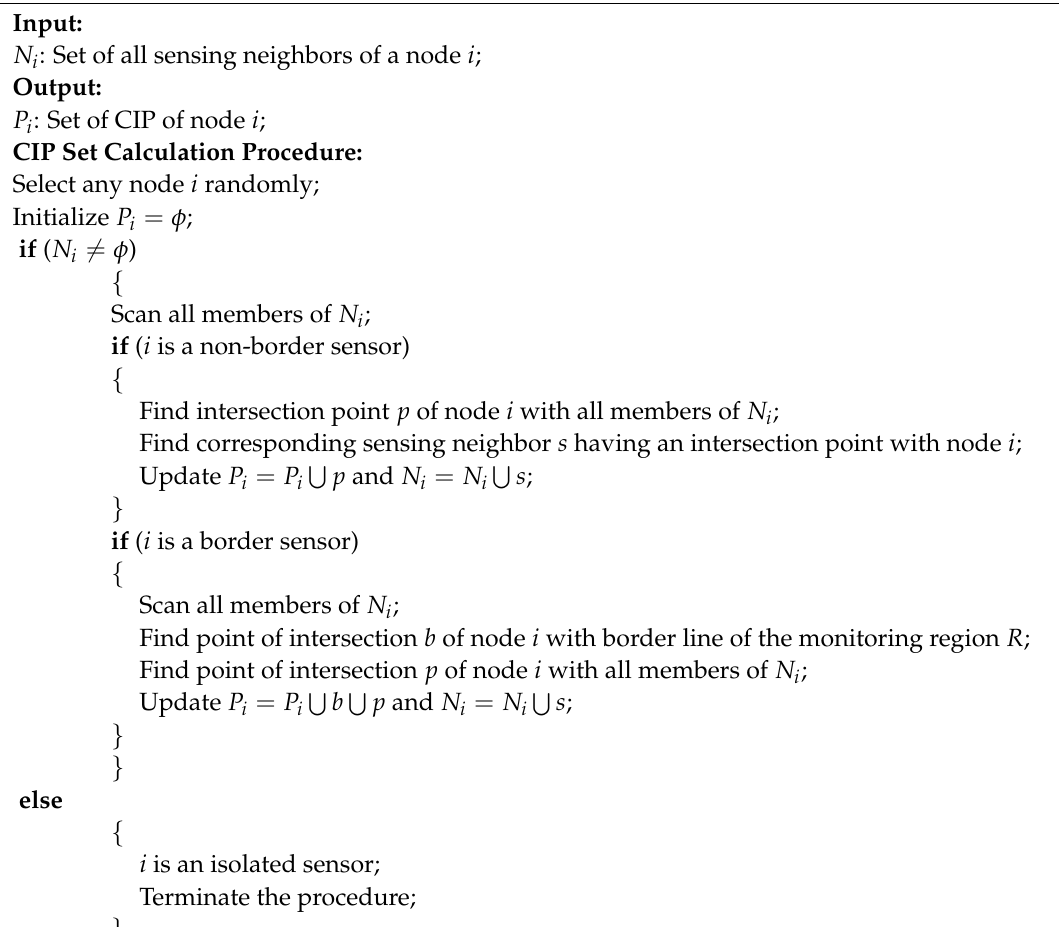
Algorithm 1 Algorithm for determining CIP of a node i .